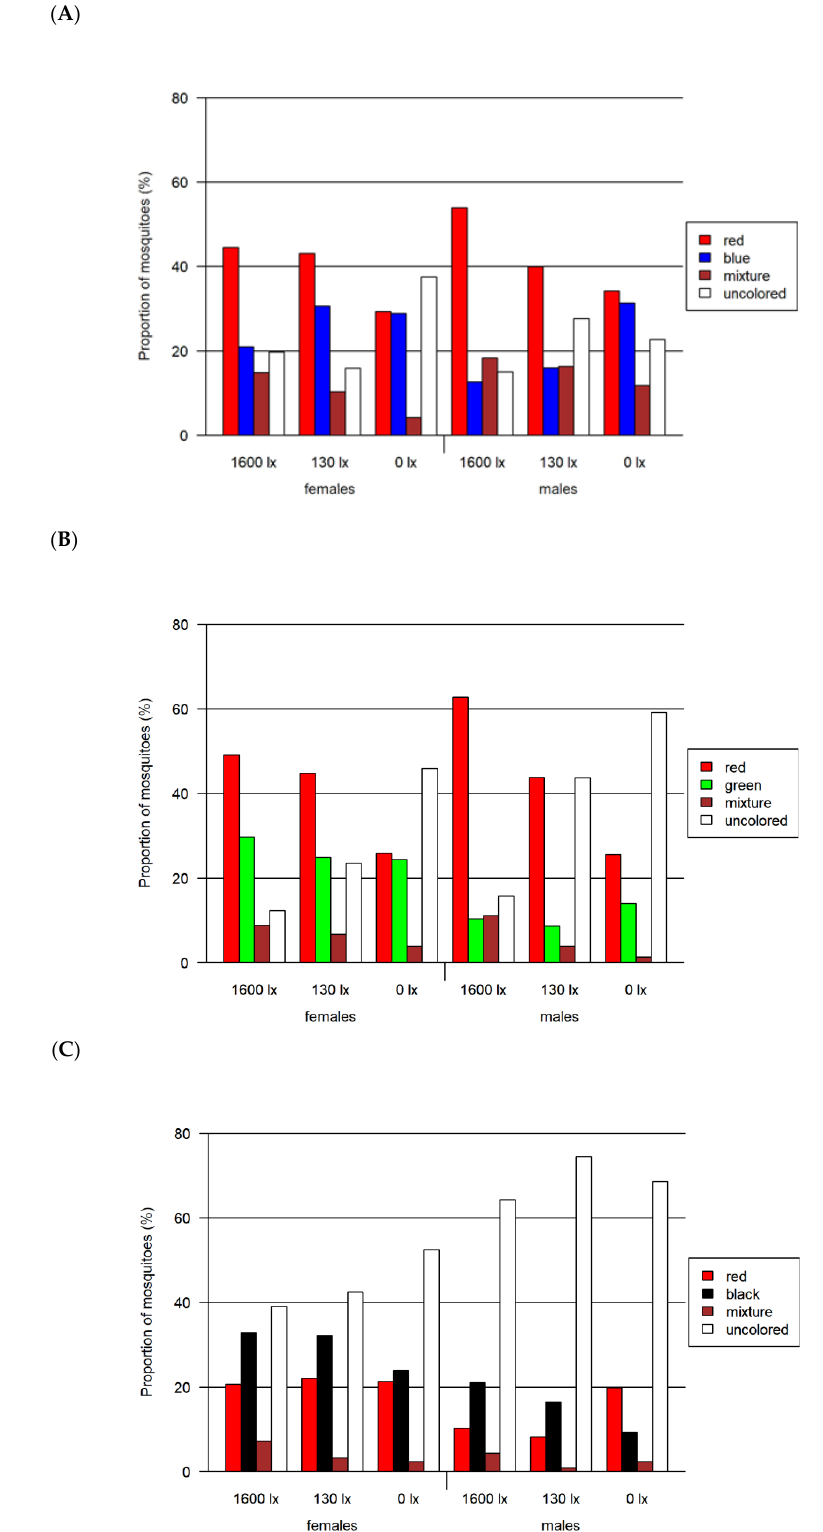
Figure 6. Results of the two-choice feeding bioassay. Left: results for females for ( A ) red-vs.-blue, ( B ) red-vs.-green and ( C ) red-vs.-black assays. Right: results only for males for the same assays. All assays were tested at three light intensities. The 1600 lx light intensity was the maximum light intensity of a 16:8 h light cycle (Light:Dark; separated by crepuscular periods; daylight at 1600 lx) while the 130 lx and the 0 lx bioassays were at constant light intensity. The given proportion of mosquitoes is normalized by setting of lux. In all three two-choice assays, male and female mosquitoes differed significantly in their choice of color ( p < 0.0001 for all likelihood ratio tests). Overall, the proportion of uncolored mosquitoes was greater for lower light intensities (Table 2 and Figure 6), while the proportion of mixed-colored mosquitoes decreased with decreasing light intensity (Figure 6). The overall proportion of females that had ingested a colored solution (67.9% colored) was larger than for the males (57.4% colored). In all assays, the largest difference of around 20% between both sexes was detected at 130 lx.